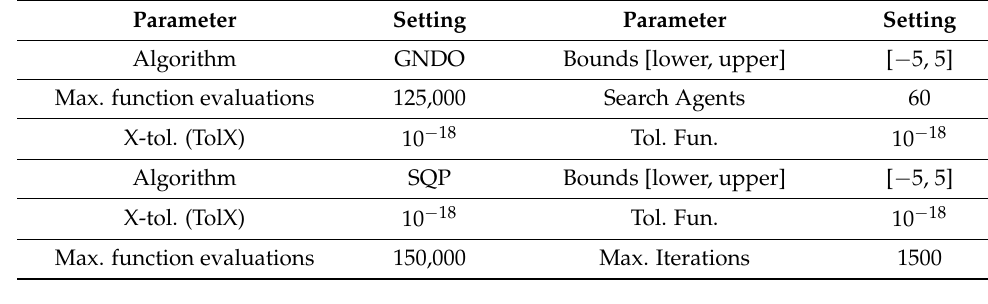
Table 1. Parameter settings for the execution of the ANN-GNDO-SQP algorithm. Parameter Setting Parameter Setting